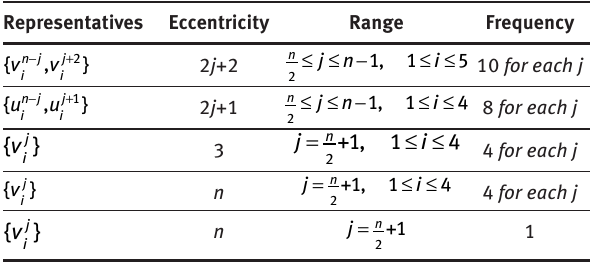
Table 3: Eccentricity based vertex partition of FCC ( n ) for n ≡